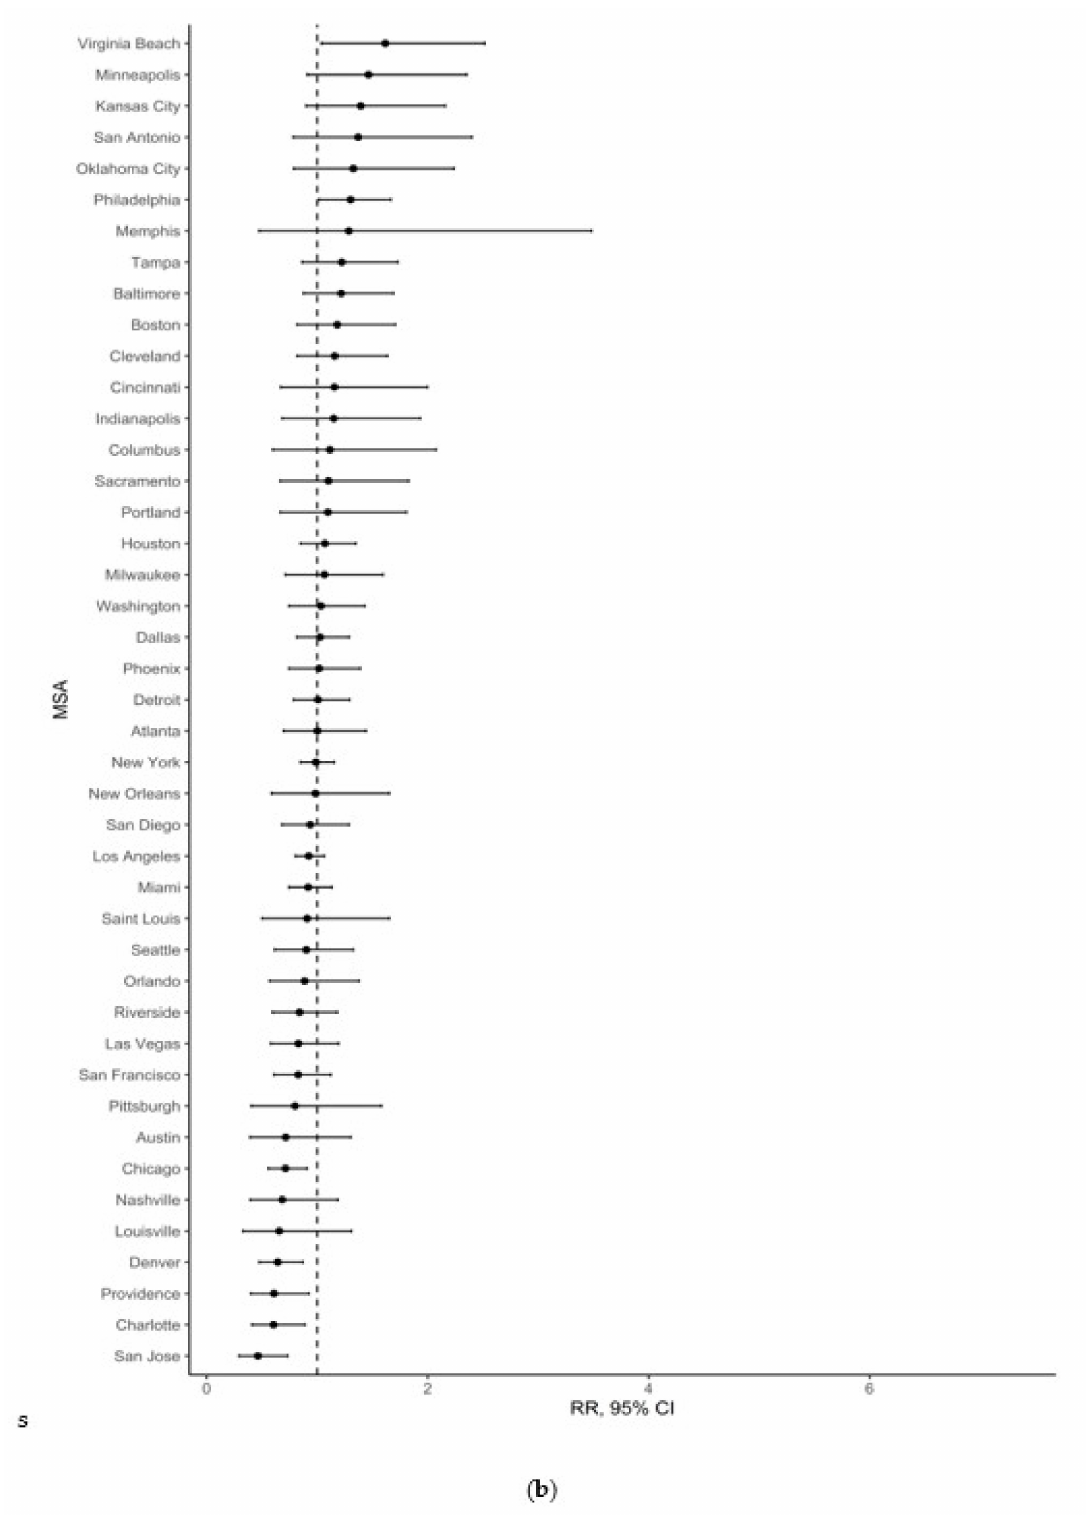
Figure 3. MSA-specific risk ratio (RR) and 95% confidence interval (CI) estimates of association between percentage greenspace and any gentrification, adjusted for population density, for the periods ( a ) 1990–2000 or ( b ) 2000–2010. Estimates for the 1990–2000 period represent comparisons of census tracts with percentage greenspace >75th percentile vs. ≤ 50th percentile for their MSA. Estimates for the 2000–2010 period represent comparisons of census tracts with percentage greenspace >75th percentile vs. ≤ 75th percentile for their